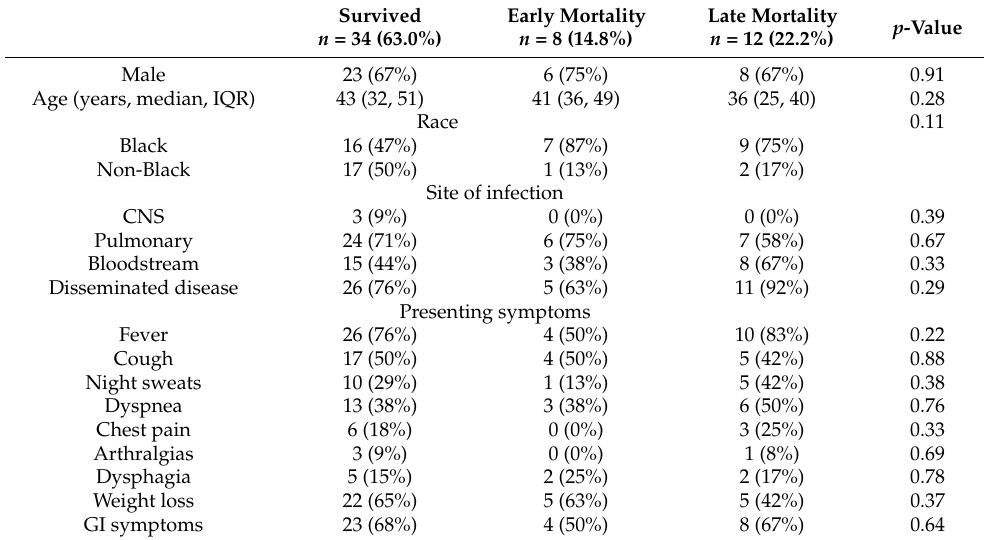
Table 1. Baseline characteristics and presentation of PWH with histoplasmosis ( n = 54) among three groups (survivors, early mortality, and late mortality) 2002–2017.